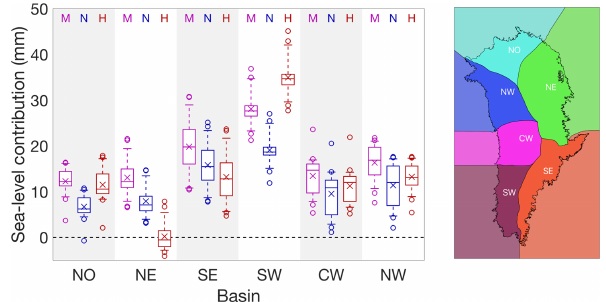
Figure 8. Regional analysis of ice sheet changes for the three core GCMs (MIROC5–M, NorESM–N, HadGem2-ES–H) under sce- nario RCP8.5. The box plots show the ensemble median (line), mean (cross), interquartile range (box), range (whiskers) and out- liers (circles). The basin definition is based on the IMBIE2-Rignot delineation (Rignot et al., 2011).